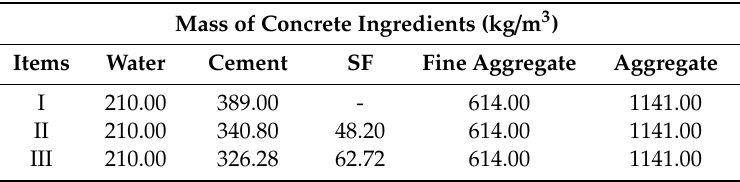
Table 1. Mix proportion of concrete with di ff erent SF levels by weight.